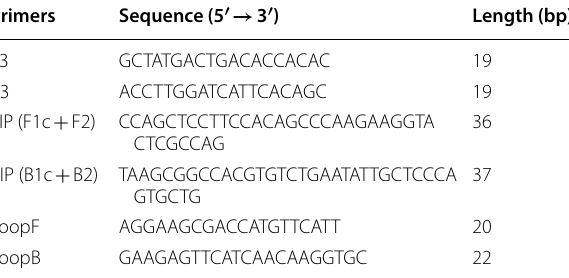
Table 1 The primer NS5-1 used for detection of Zika virus